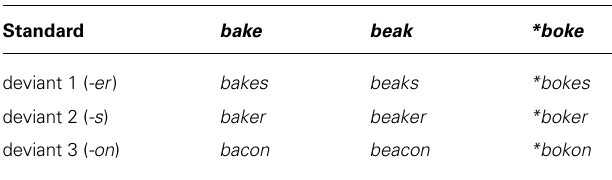
Table 1 | Standards and deviants used in MMN